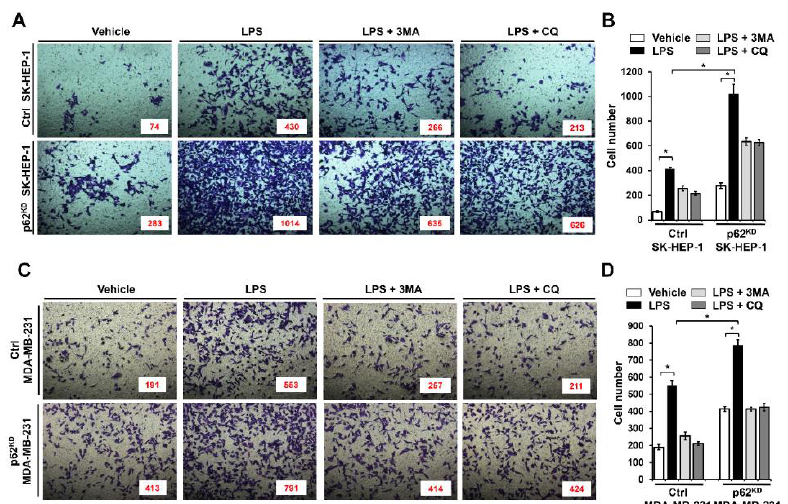
Figure 5. p62 KD SK-HEP-1 and p62 KD MDA-MB-231 cells exhibit increased invasiveness in response to TLR4 stimulation. ( A , B ) Ctrl and p62 KD SK-HEP-1 cells were suspended in DMEM culture medium including vehicle, LPS (10 μ g/mL), 3-MA (5 mM) plus LPS (10 μ g/mL) , and CQ (10 μM) plus LPS (10 μ g/mL). Cells were placed into the top chambers of 24-transwell plates and incubated for overnight. Fixed cells were stained by using crystal violet ( A ). Numbers of migrated cells were counted, and results are represented as mean ± SEM ( B ).* p < 0.05. ( C , D ) Ctrl and p62 KD MDA-MB-231 cells were suspended in culture medium of RPMI including vehicle, LPS (10 μ g/mL), 3-MA (5 mM) plus LPS (10 μ g/mL) , and CQ (10 μM) plus LPS (10 μ g/mL). Cells were placed into top chambers of 24-transwell plates and further incubated for overnight. Fixed cells were stained with crystal violet ( C ). Numbers of migrated cells were counted, and results are represented as mean ± SEM ( D ).* p < 0.05.